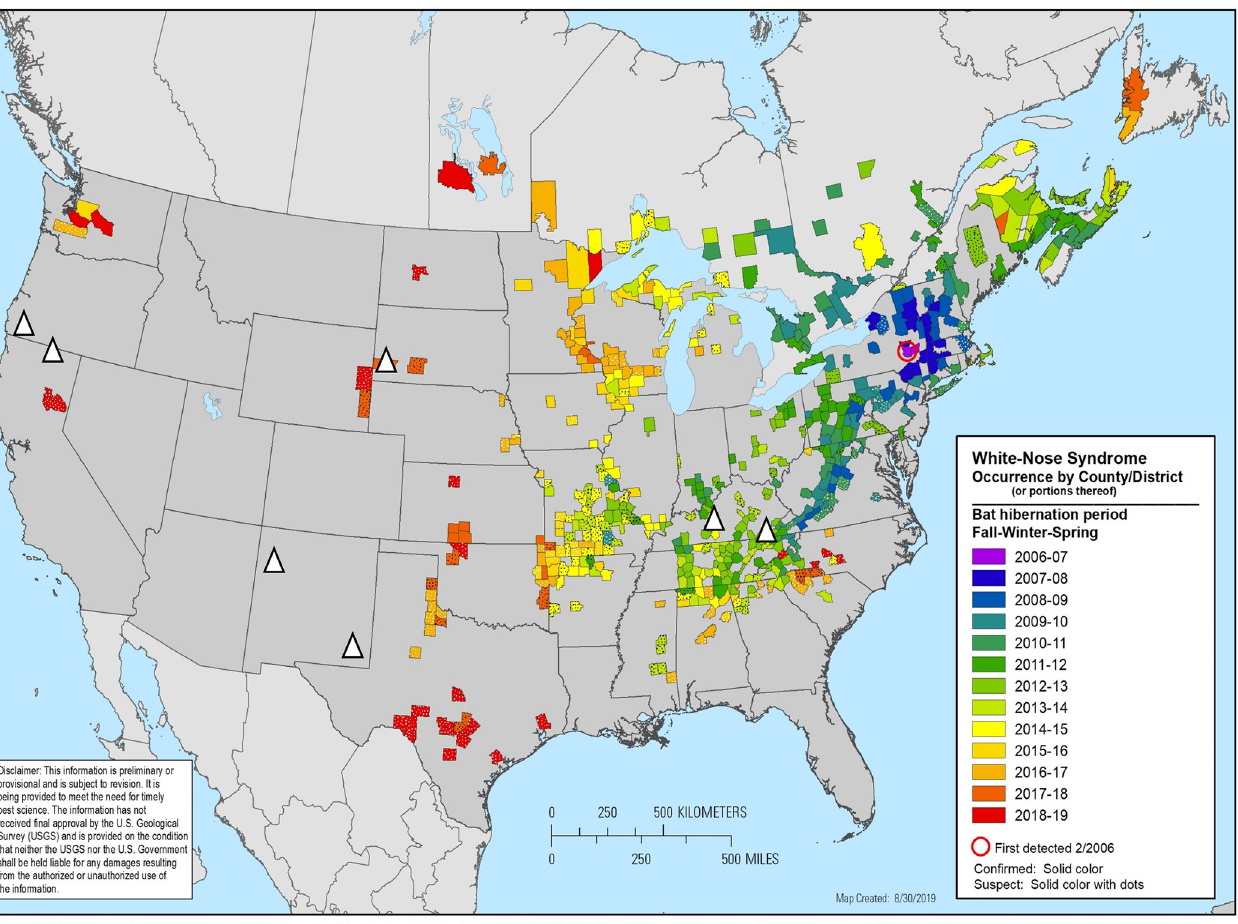
Fig 1. White-nose syndrome occurrence map at the time of our study. The triangles represent the locations of the national park areas we surveyed visitors were located. Wind and Jewel Cave (South Dakota) are located close to each other (approximately 47 km apart), so they are represented by a single triangle. Version from August 30, 2019, updated by the United States Fish and Wildlife Service. Available at